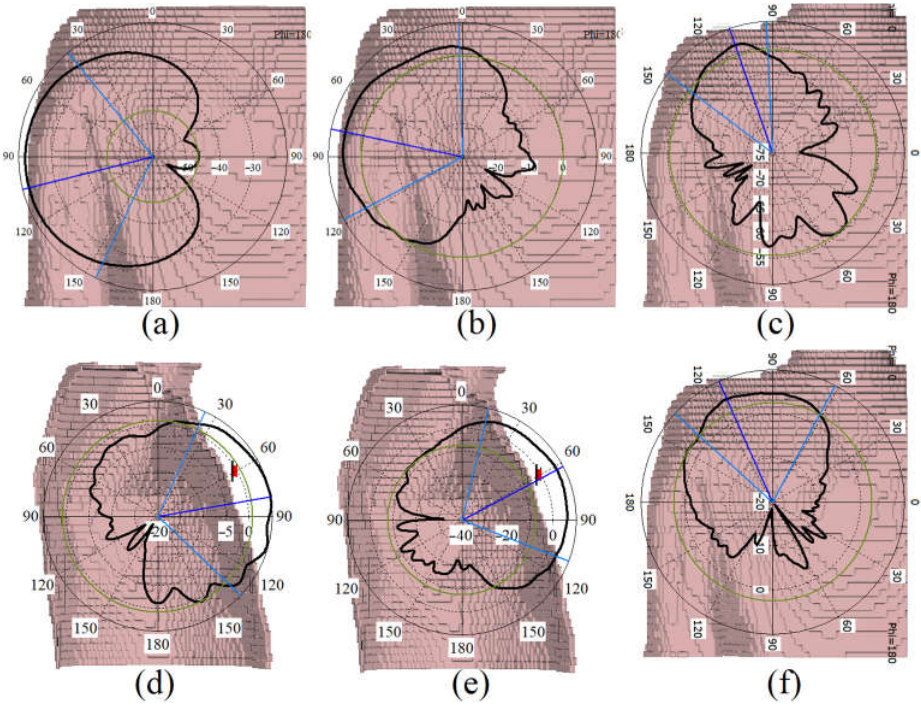
Figure 15. The simulated radiation pattern of the antenna on the arm (parts ( a ) at 3.4 GHz and ( b ) 5.6 GHz), on the shoulder (parts ( c ) at 3.4 GHz, ( f ) at 5.6 GHz), and on the chest (parts ( d ) at 3.4 GHz, ( e ) at 5.6 GHz).